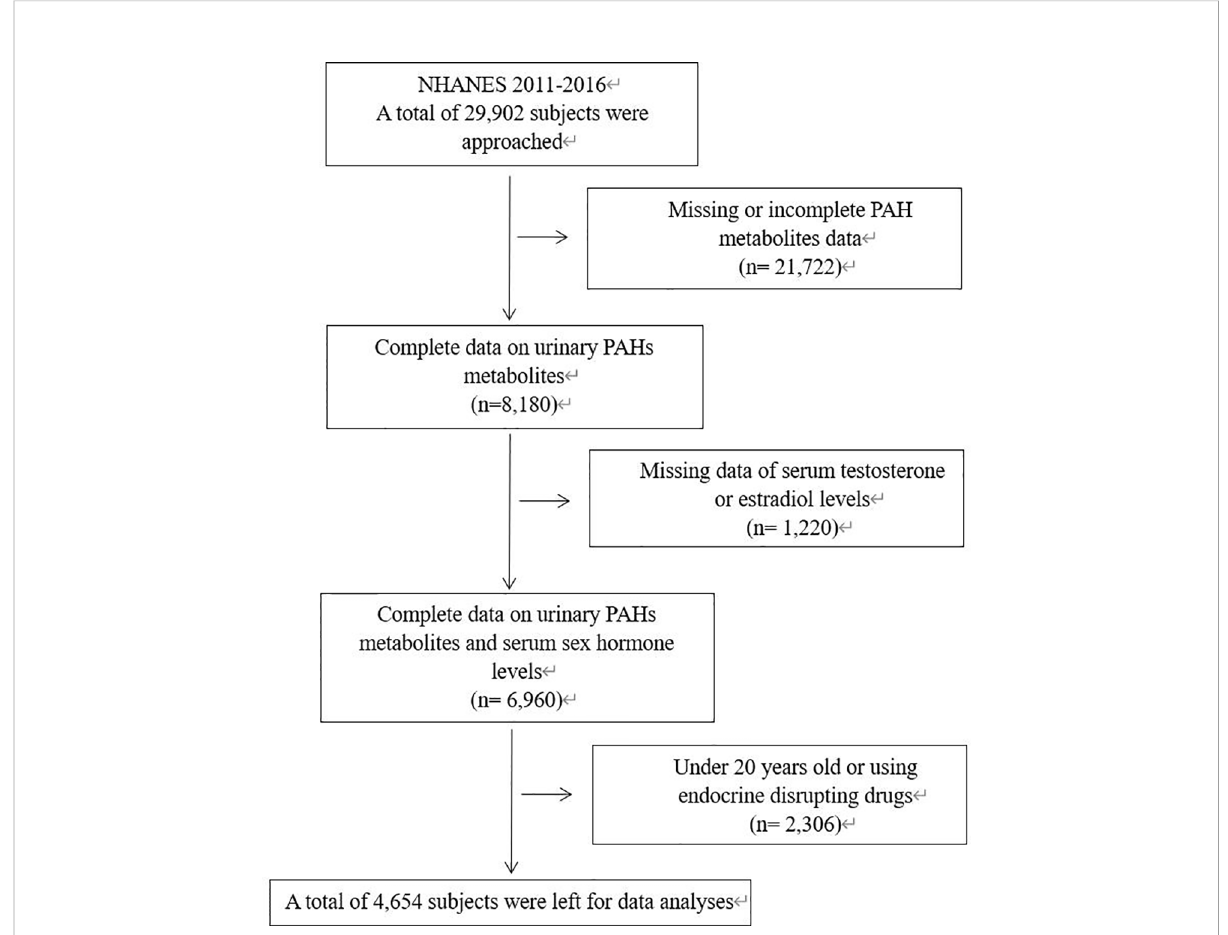
FIGURE 1 Flowchart describing the selection of patients. NHANES, National Health and Nutrition Examination Survey; PAH, Polycyclic aromatic